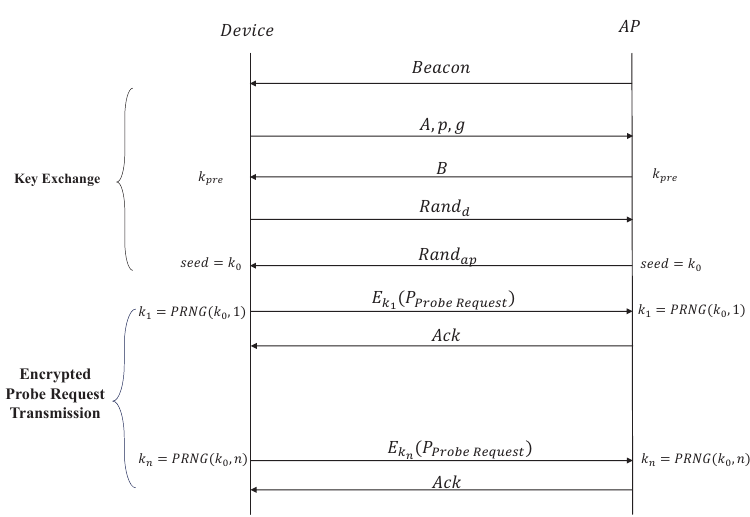
Figure 7. Frame exchange in defense